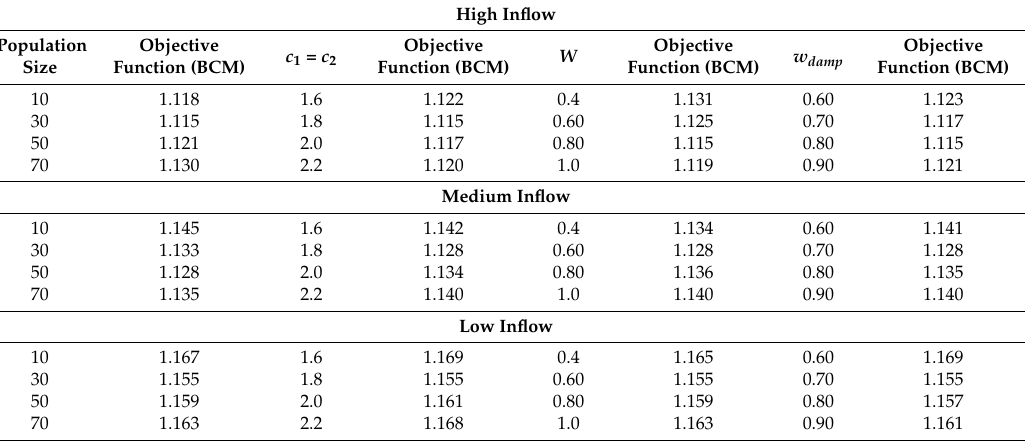
Table 4. Sensitivity Analysis for IPSOA.